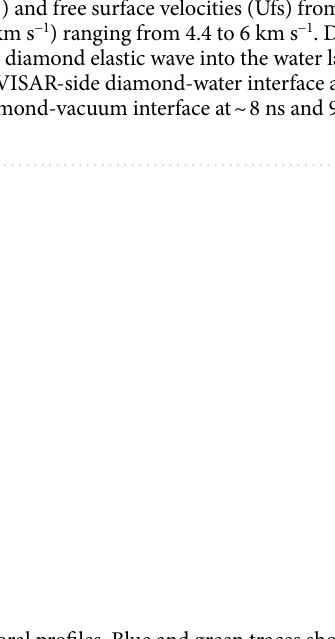
Figure 6. Oscilloscope traces of drive laser temporal profiles. Blue and green traces show the two 10 ns flat-top profiles offset by ~ 5 ns to yield a stepped ~ 15 ns drive pulse profile. Two separate laser ‘arms’ are combined to generate the compression wave, here labeled AB and EF corresponding to names of the capacitor banks. The total irradiance as seen by the target is the sum of the two drive profiles shown by the dotted black